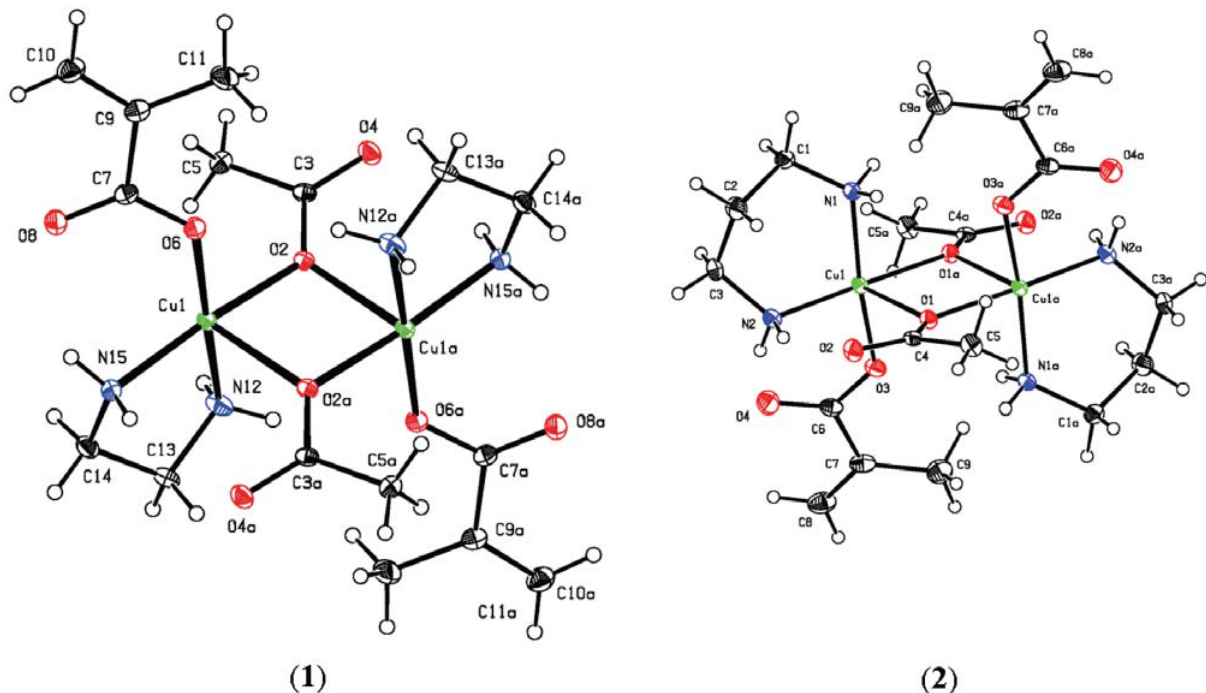
Fig. 1. The ORTEP view of complexes 1 and 2 showing 30% probability thermal ellipsoids. Symmetry codes: – x , – y + 2, – z + 1 for 1 and x + 1, – y + 1, – z + 1 for 2